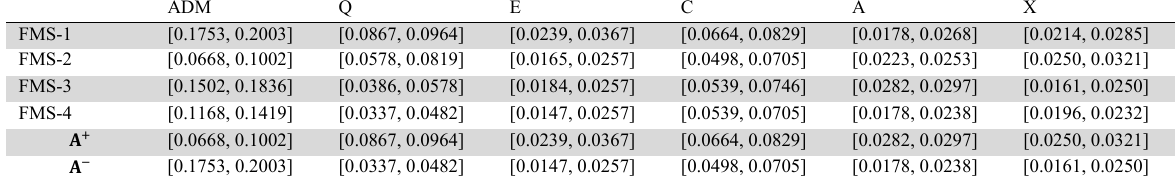
Weighted normalised interval valued decision matrix ADM Q E C A X FMS-1